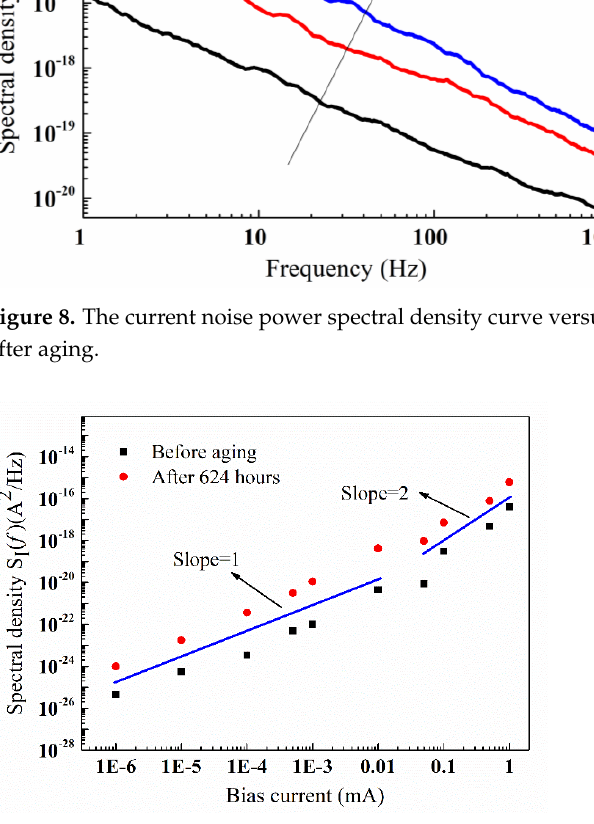
Figure 9. The current noise power spectral density (20 Hz) of the sample under different bias